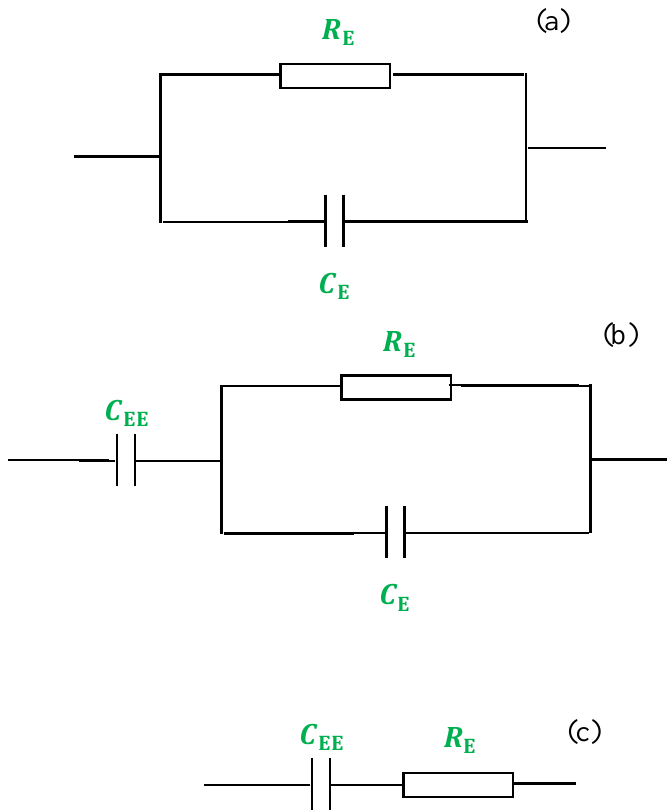
Figure 6. Schematic illustration of the electrical equivalent circuits (EECs) for ( a ) parallel combination of a resistor and capacitor, ( b ) parallel combination of a resistor and capacitor and in series with another capacitor and ( c ) series combination of a resistor and capacitor. Resistor is represented by the symbol and capacitor represented by . Table 1. Conductivity for pure CS:Ddextran and blended electrolyte films at room temperature.